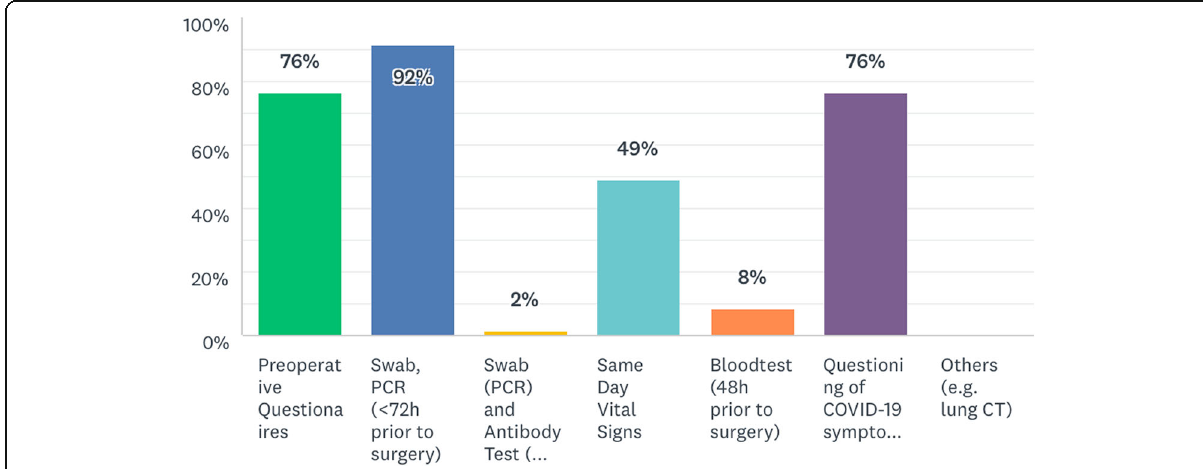
Fig. 4 Preoperative patient testing prior to elective surgery (preoperative COVID-19 questionnaires; COVID-19 swab PCR test < 72 h prior to surgery; COVID-19 swab PCR test and antibody testing; same-day vital signs monitoring; blood test for inflammatory signs < 48 h prior to surgery; questioning of COVID-19 symptoms on same day of surgery;